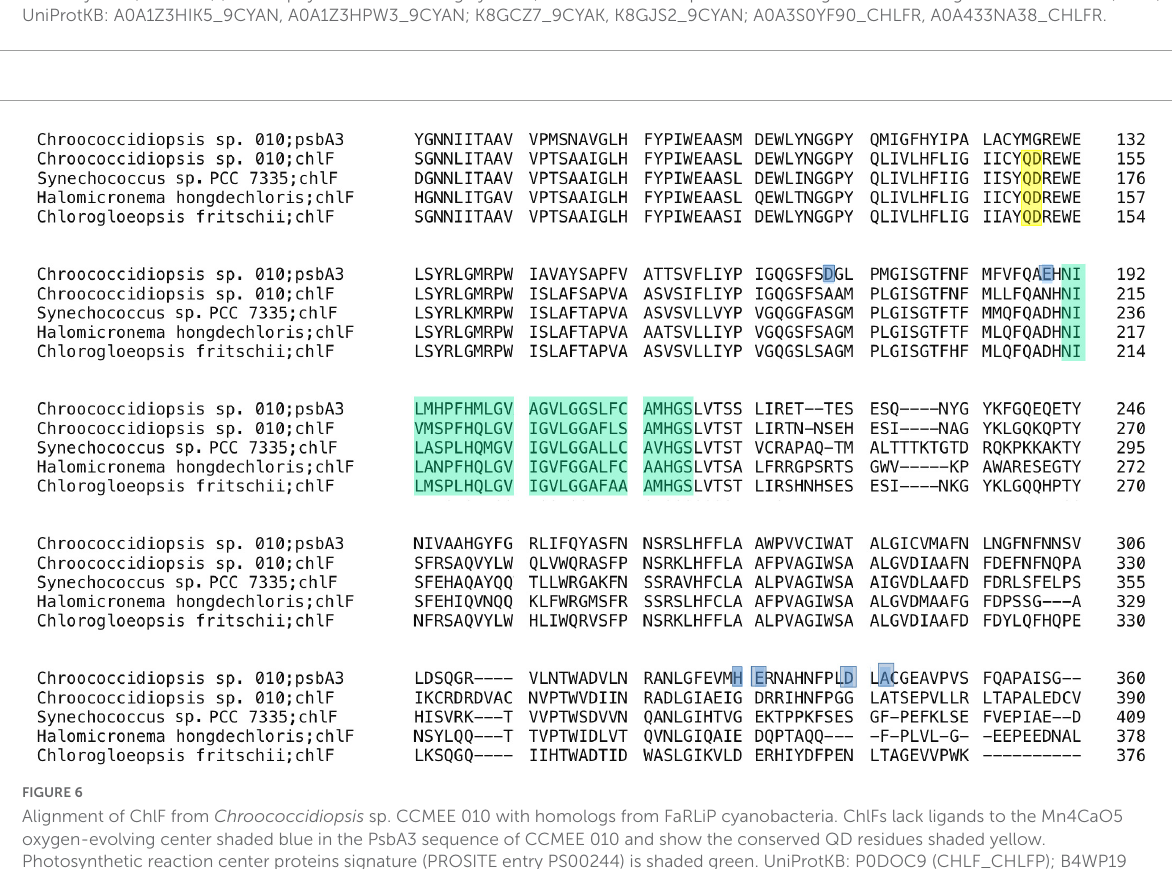
FIGURE5 Alignment of ApcEs from Chroococcidiopsis sp. CCMEE 010 with homologs from FaRLiP cyanobacteria. Conserved ENACS-motif of ApcE1 is shaded yellow, asterisk ( ∗ ) shows phytochrome-binding cysteine, VIPEDV-motif of ApcE2 is shaded light red according to Antonaru et al. (2020).